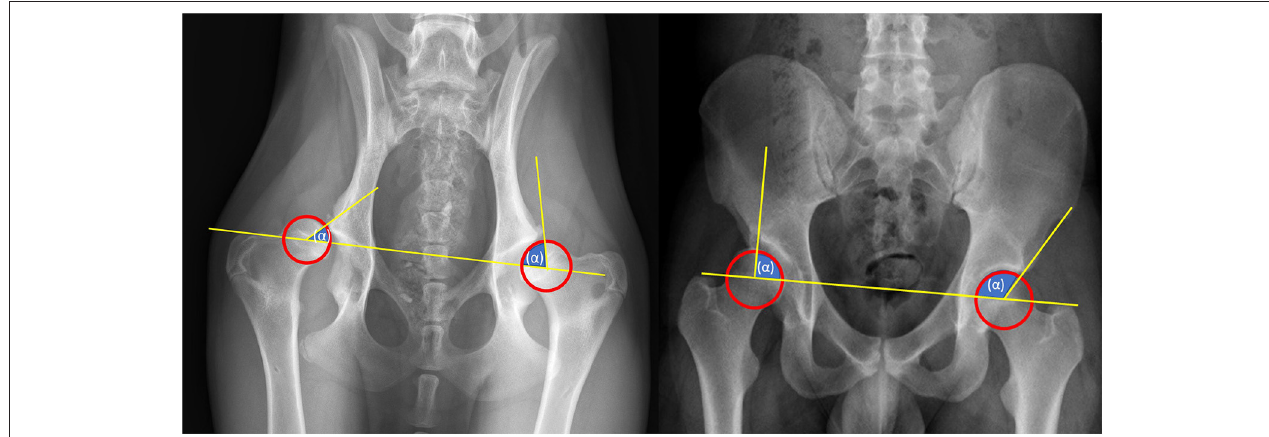
FIGURE 4 | Radiographic diagnostics. Left: Norberg-Angle, take the center of each femoral head (hip ball) and draw a line between them. Then take the center of the femoral head and draw a line to the outer point of the pelvis. The angle between these lines is the Norberg angle. The Norberg angle is calculated for each hip joint. A normal Norberg Angle ranges from 100/105 to 115 degrees. < 100 degrees is dysplastic. Right: CE-angle, take the center of each femoral head (hip ball) and draw a line between them. Then take the center of the femoral head and draw a line to the outer point of the pelvis. The angle between these lines is the CE angle. The CE-angle is calculated for each hip joint. A normal CE Angle ranges from 110/115 to 130 degrees. < 110 degrees is